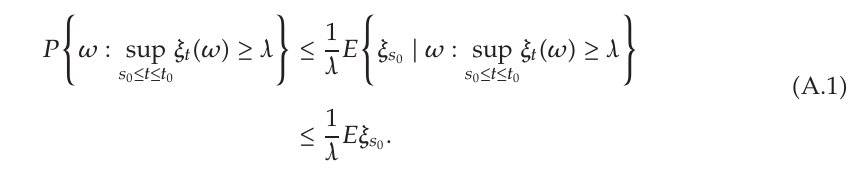
(cid:3) 1 (cid:4) (cid:9) 0, u ∗ (cid:3) 2 (cid:4) (cid:9) i i